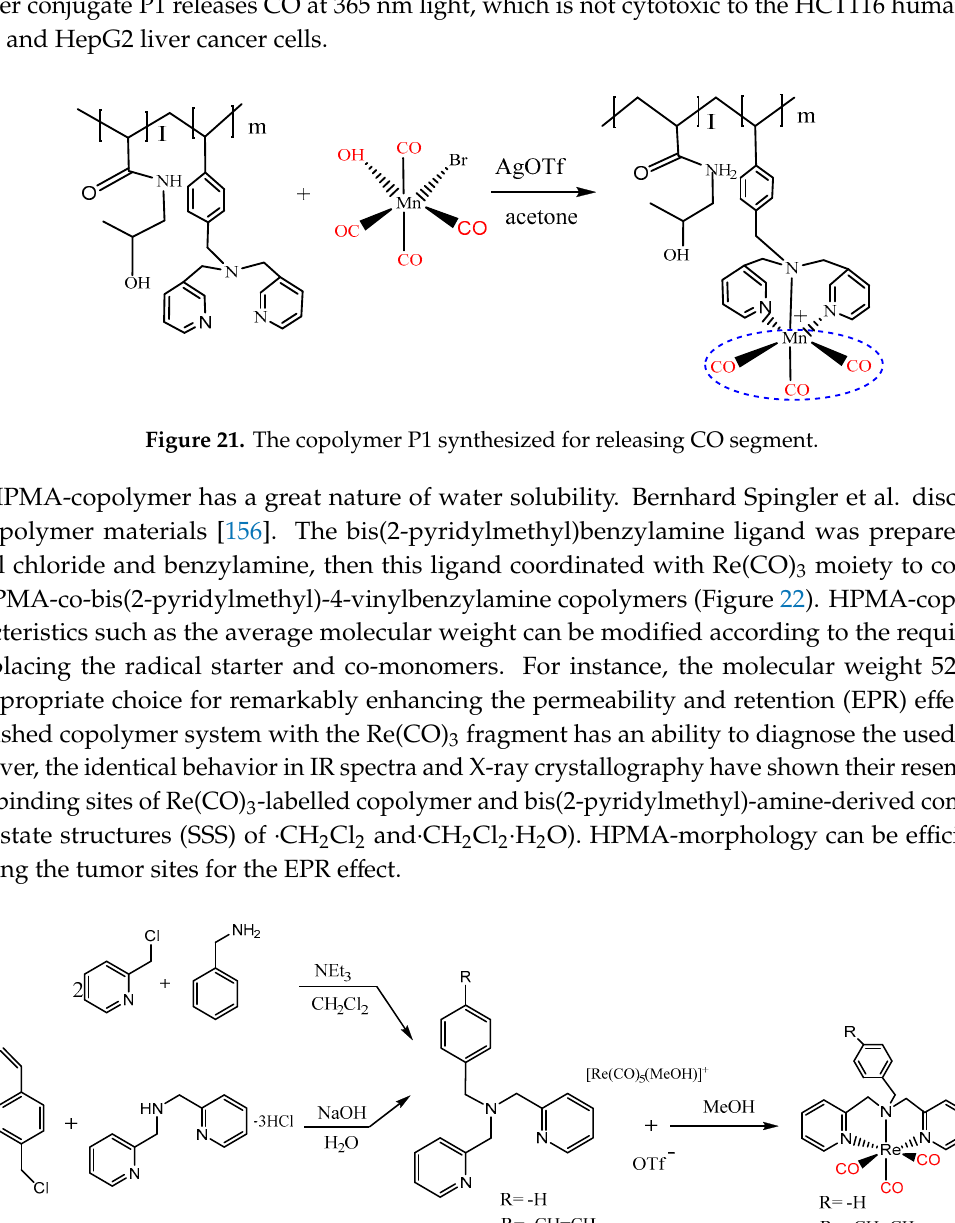
Figure 22. The copolymers HPMA ‐ co ‐ bis(2 ‐ pyridylmethyl) ‐ 4 ‐ vinyl ‐ benzylamine construct through Re(CO) 3 moiety.